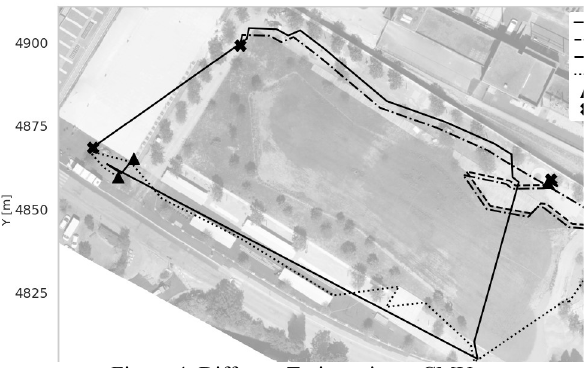
Figure 4. Different Trajectories at CMU Table 1. Residuals of the four trajectories The RMSE in both horizontal and vertical direction are surprisingly small considering the travelled distances in the range of 114 meters to 350 meters. Table 2 indicates the maximum error in each direction with respect to the travelled distance (both absolute in meters and relative to the total trajectory length). The maximum horizontal error of all campaigns is 3.9 meters after 258 meters along the trajectory in campaign number 3. The maximum vertical error is 2.2 meters after 282 meters in campaign number